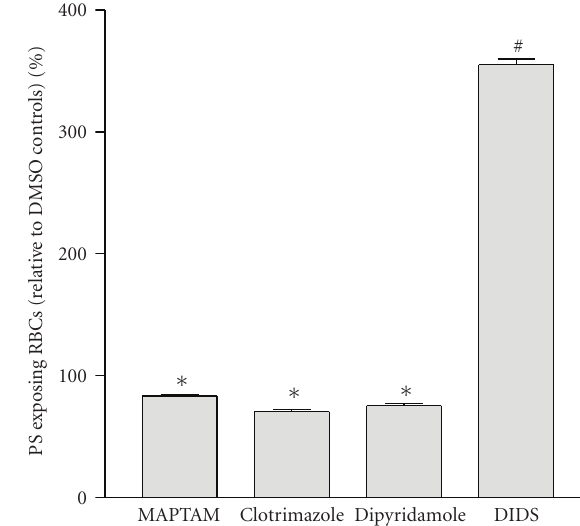
Figure 2: E ff ect of inhibitors on phosphatidylserine (PS) exposure in red blood cells (RBCs) from sickle cell patients. RBCs were incubated under deoxygenated conditions (1% O 2 ) for 3 hours (5mM extracellular [Ca 2+ ]) after which they were labelled with FITC-annexin. Four conditions (all with 0.5% DMSO) are shown: MAPTAM-treated RBCs (loaded with 5 μ M MAPTAM prior to deoxygenation), clotrimazole (10 μ M), dipyridamole (50 μ M), and DIDS (50 μ M). Results are presented as percentage PS exposing RBCs relative to control RBCs exposed to 0.5% DMSO only. Histograms represent means ± S . E . M . ( n = 3). ∗ P < . 01 and